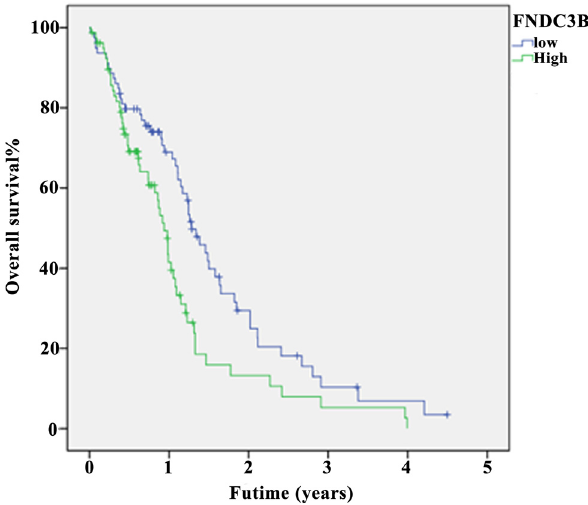
Figure 5: Overexpression of FNDC3B caused poor prognosis in glioblastoma. The relationship between the FNDC3B level ( high [> 1965.248214, n = 79 ] or low [< 1965.248214, n = 79 ]) and glioblastoma patients ’ survival was assessed based on TCGA